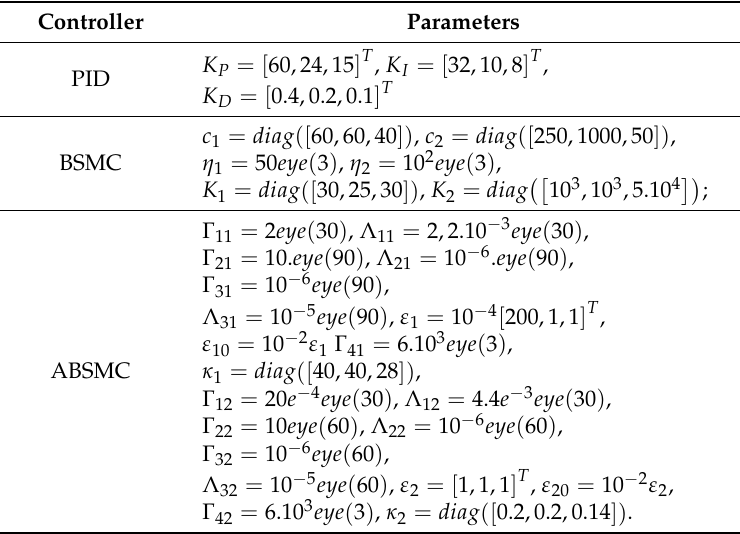
Table 2. Control